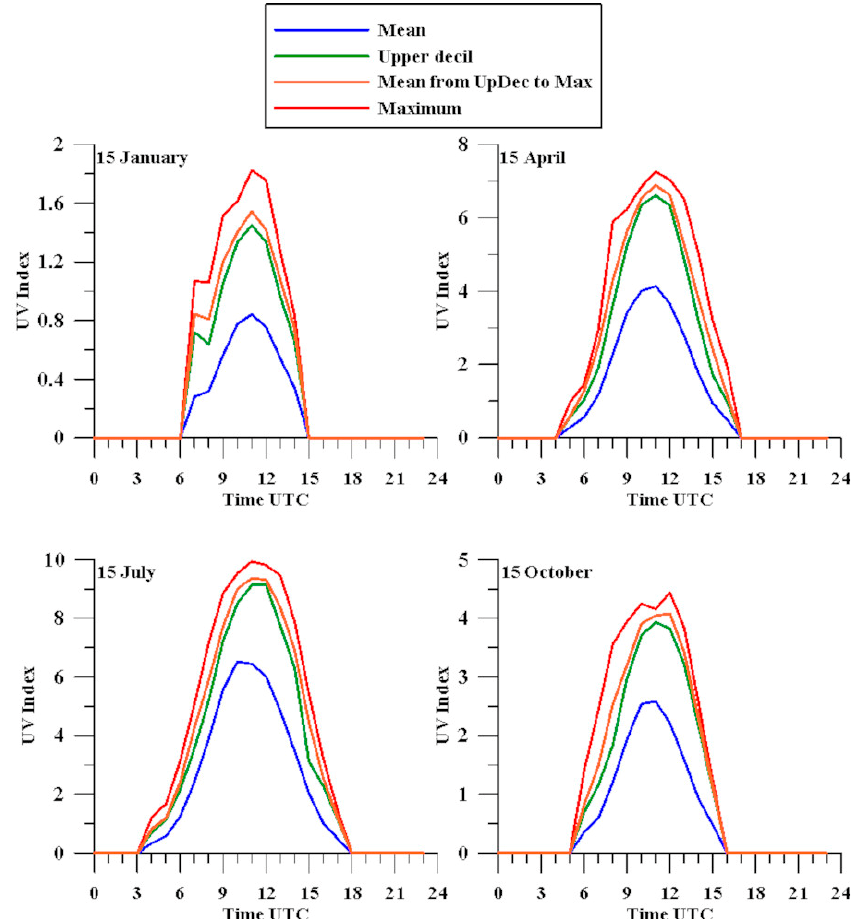
Figure 3. Illustration the mean values (blue solid line), the upper decile (green solid line), the maximum values (red solid line) and the estimated values of the UV-Index in clear weather obtained by the proposed methodology—mean values from upper decile to maximum (orange solid line) for four days of the year (15 January ( upper left ), 15 April ( upper right ), 15 July ( lower left ), 15 October ( lower right )).